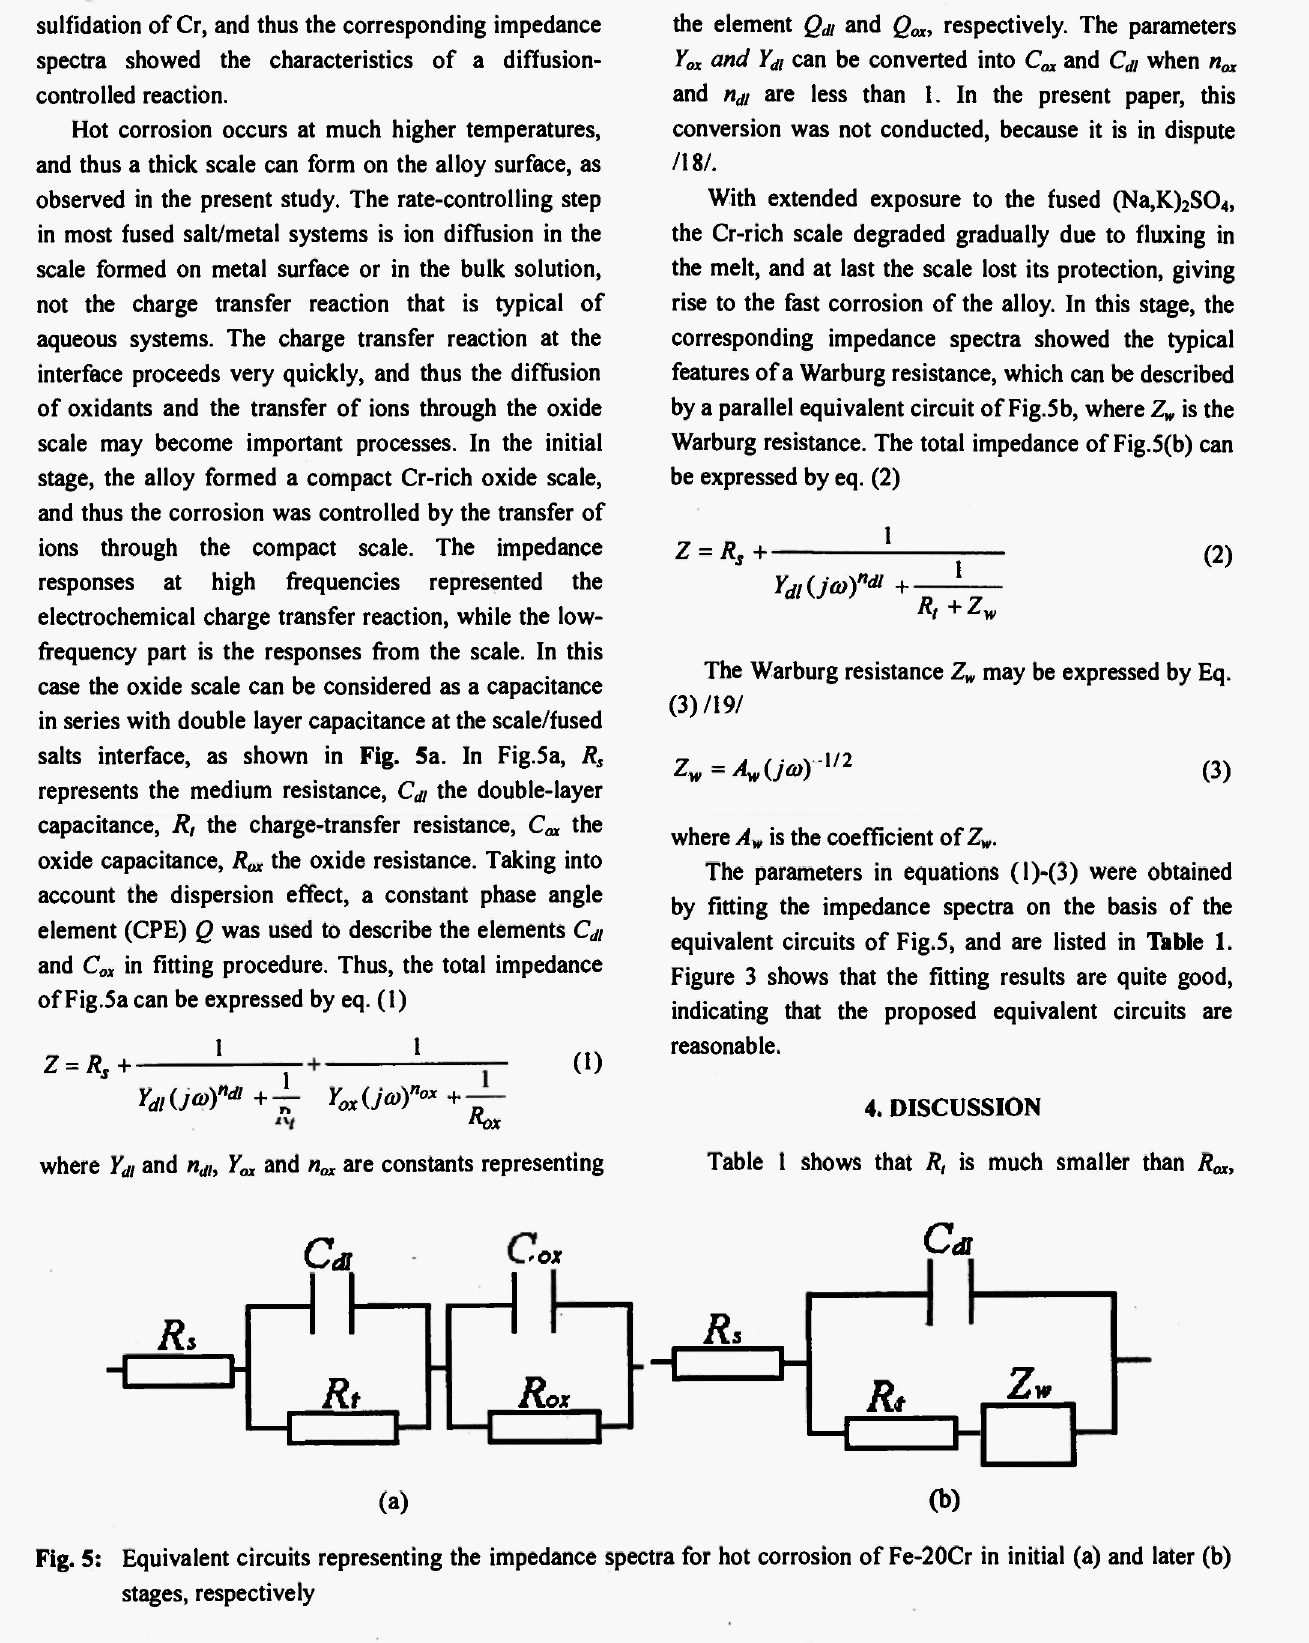
Fig. 5: Equivalent circuits representing the impedance spectra for hot corrosion of Fe-20Cr in initial (a) and later (b) stages, respectively